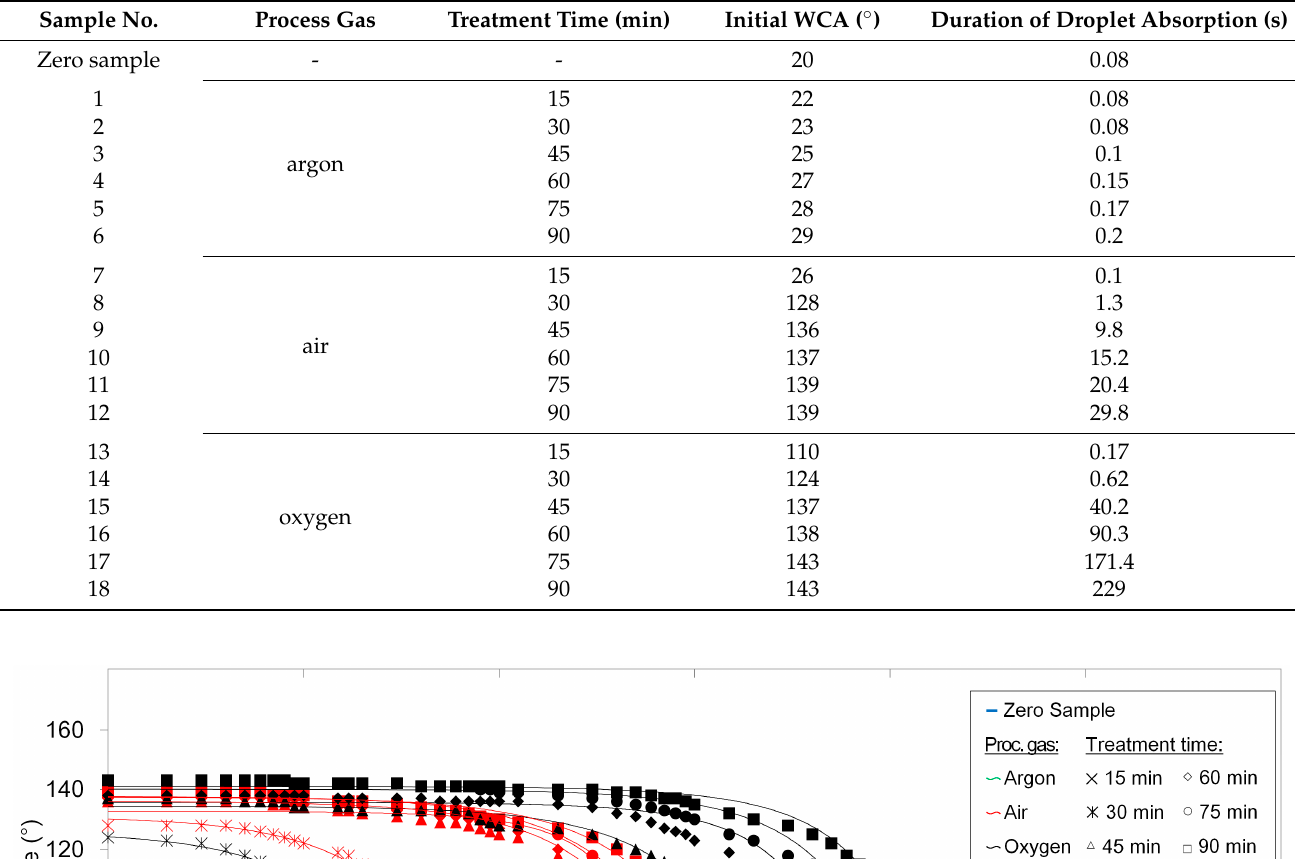
Table 1. Wettability of cellulose samples depending on the process parameters.